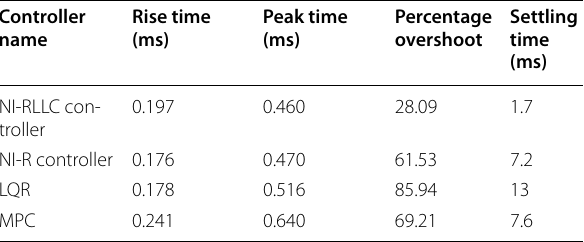
Table 5 Step response comparison of different controllers for single‑phase